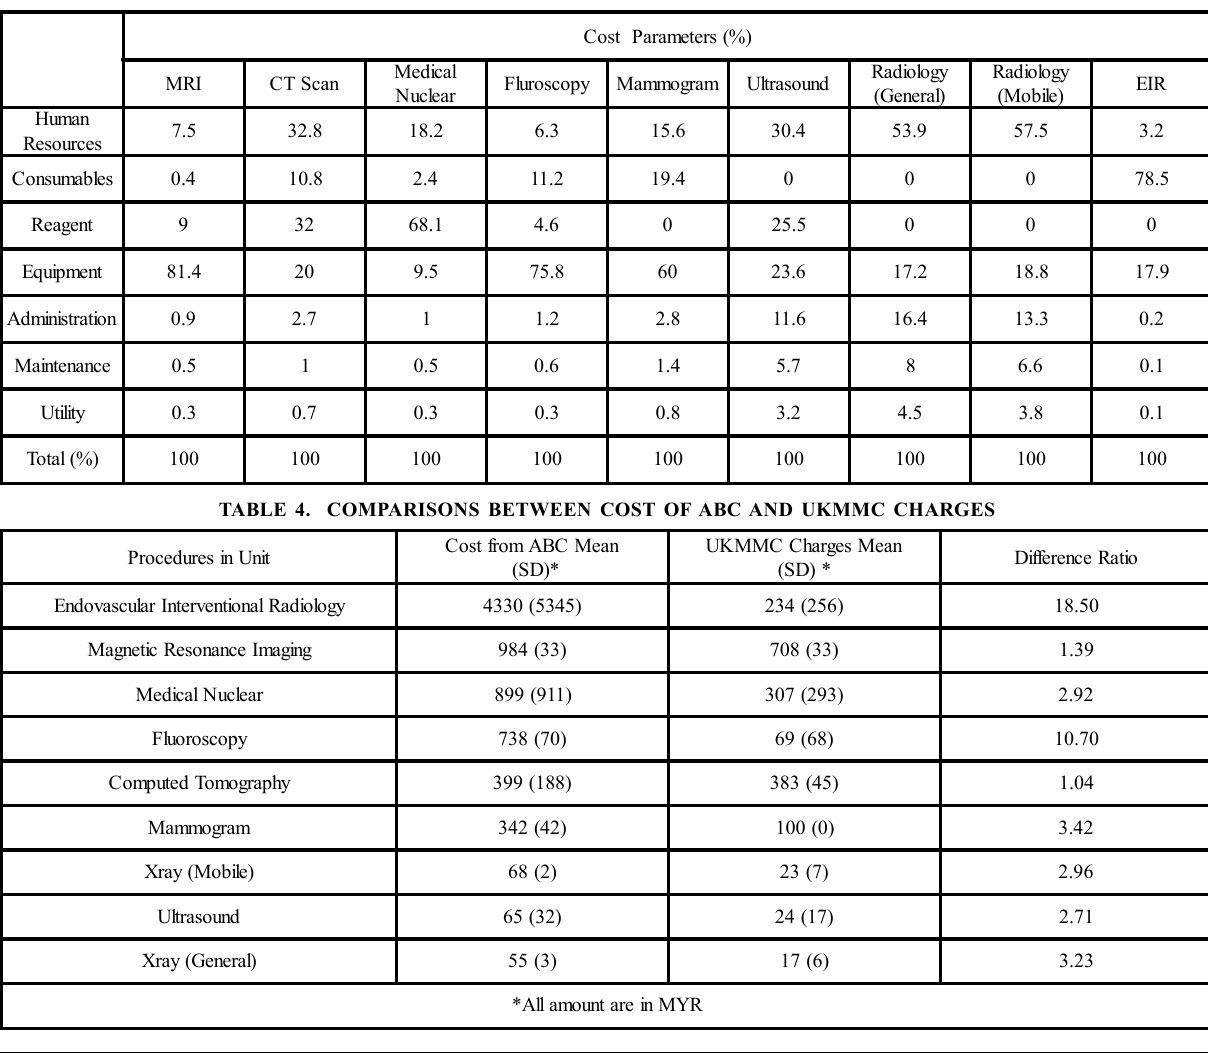
TABLE 4. COMPARISONS BETWEEN COST OF ABC AND UKMMC CHARGES